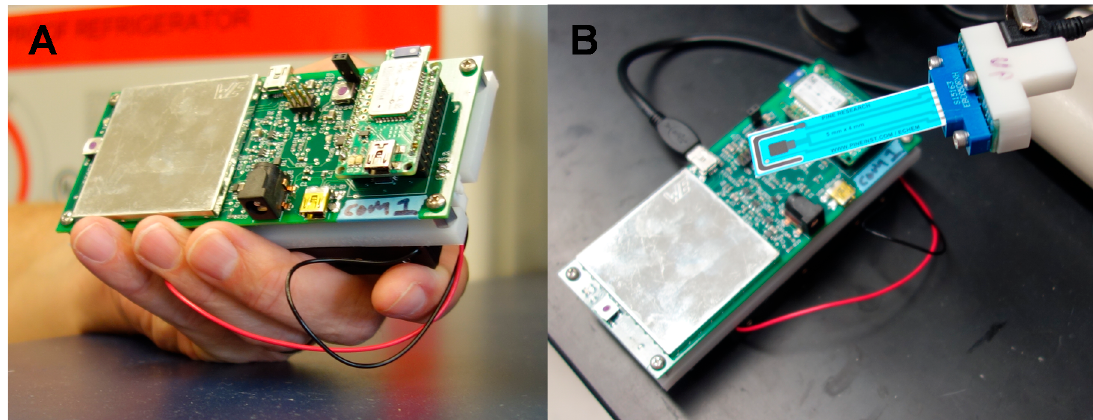
Figure 1. ( A ) The prototype instrument is 2.2” × 5.5” × 0.5” and weighs 300 g with batteries. ( B ) A standard (shielded) USB cable can be used to connect the instrument to a commercially available disposable electrode and socket. Breakout cables may also be used.